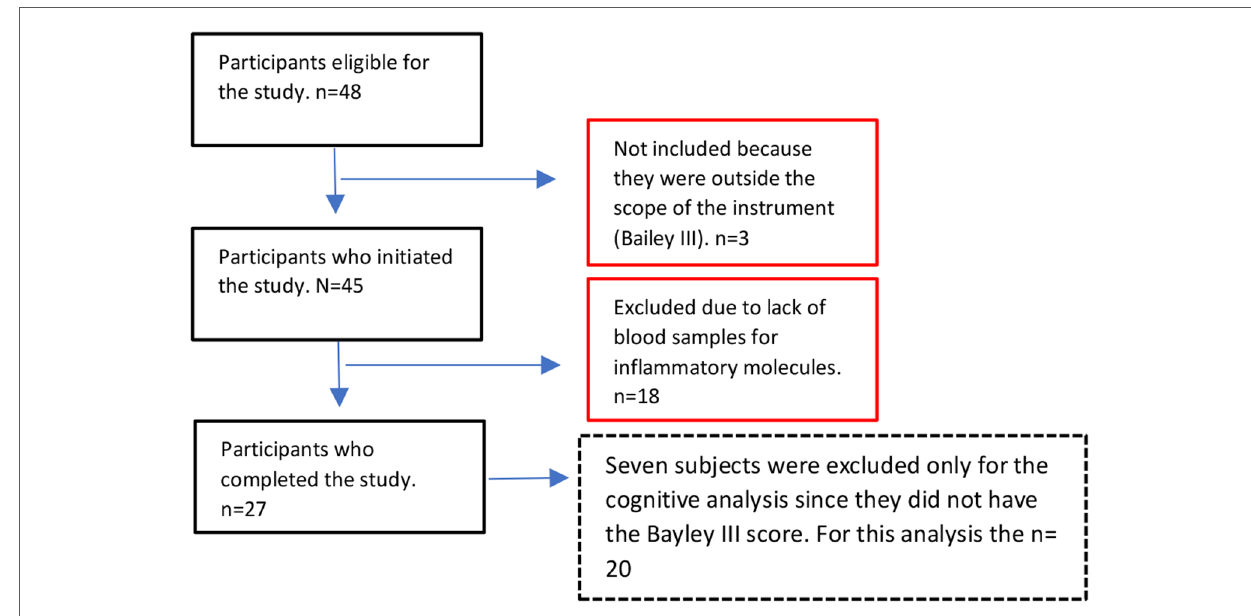
FIGURE 1 Flow chart illustrating the study sample